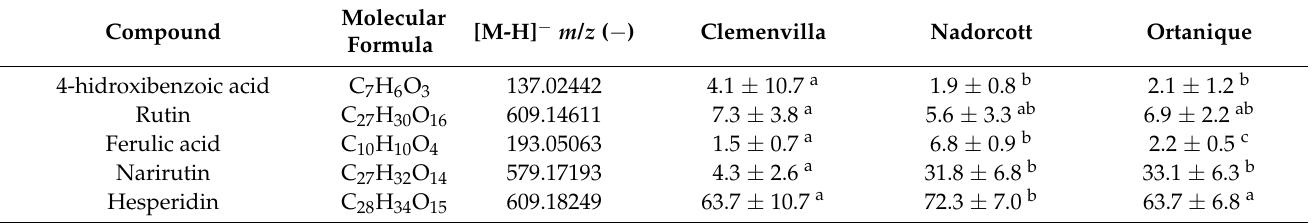
Table 2. Polyphenol compounds identified and quantified in hybrid mandarin peels by UPLC-QTOF-